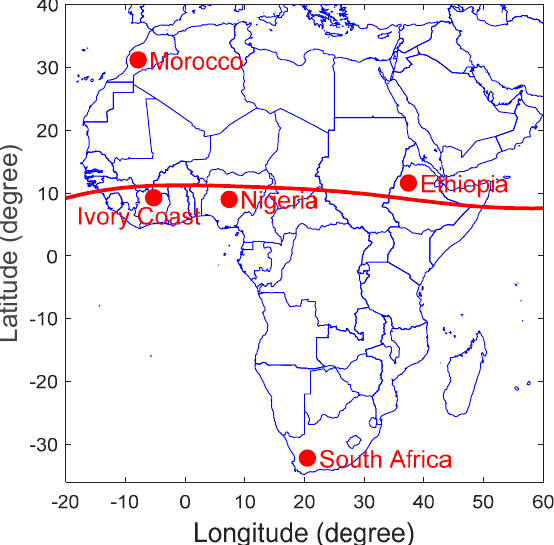
Figure 1. Map of Africa showing locations where the Fabry–Perot Interferometer studies of thermo- spheric neutral winds were conducted. The red line represents the geomagnetic equator.